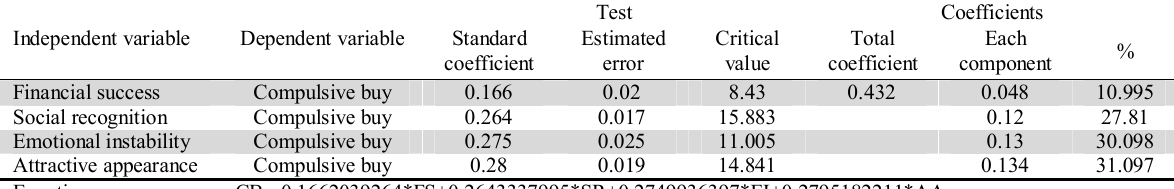
The summary of SEM